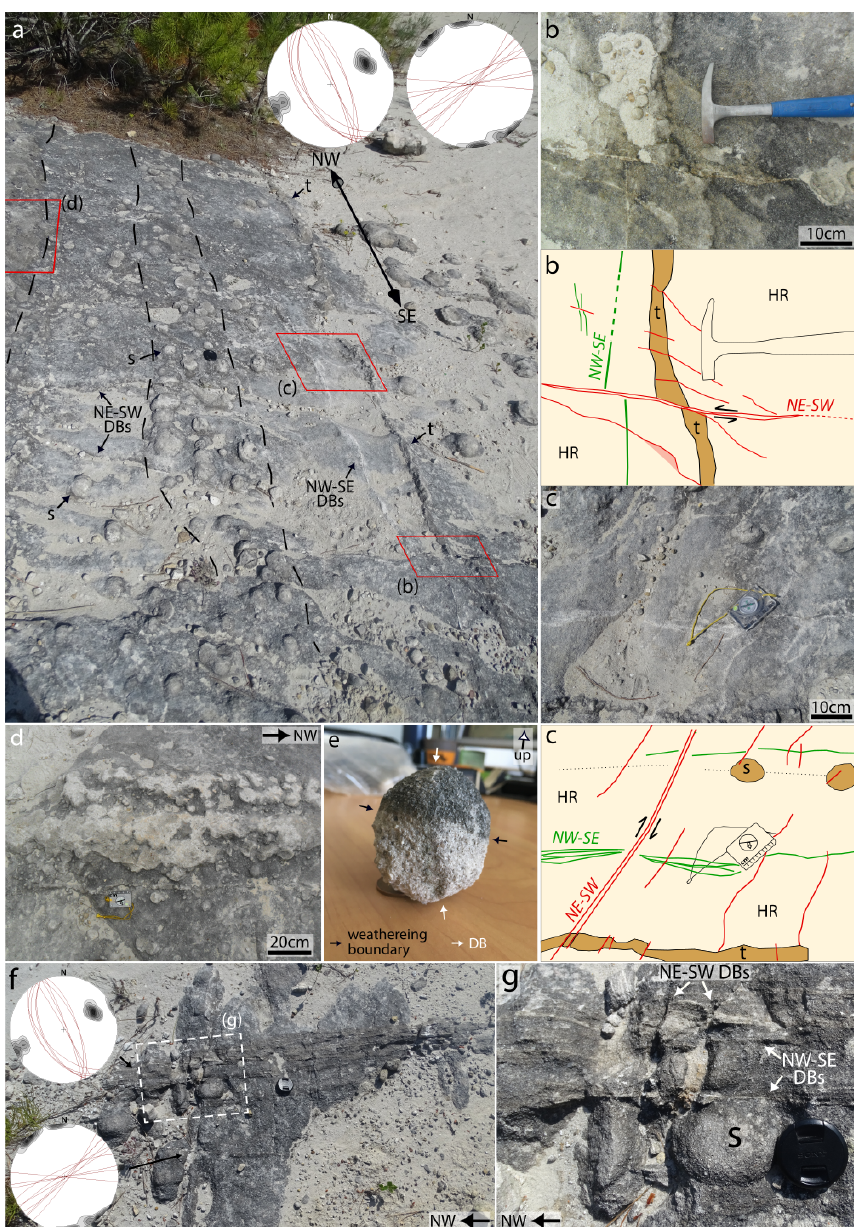
Figure 7. Calcite cement occurs isolated (a, c, g) or in clusters (a, d) of (S) spherical nodules and continuous (t) tabular nodules (a–c) . Nodules are arranged in compartments parallel to clusters of NW–SE normal bands (a–c) and to NNW–SSE dextral strike-slip bands (f, g) . NE–SW/ENE–WSW strike-slip bands displace both the NW–SE bands and their associated nodules (a–c, f) . (e) Spherical nodule (about 5cm in diameter) in spatial superposition with a NW–SE DB that does not displace the cement. The lens cover in (a, f) has a 5.5cm diameter. The figures (a–d, f, g) are in map view. The position of (a, f) is indicated in Fig. 6b. Hammer length in (b) is